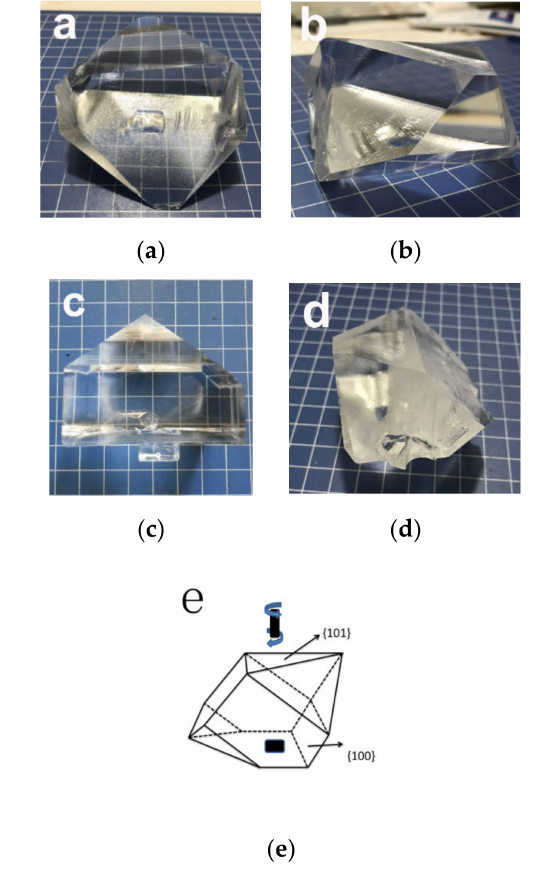
Figure 9. Photos of KDP crystals: ( a ) [101] orientation, 12 mm / day ( b ) [101] orientation 14 mm / day ( c ) Z-cut, 12 mm / day ( d ) [101] orientation 16 mm / day ( e ) schematic diagram of [101] orientation